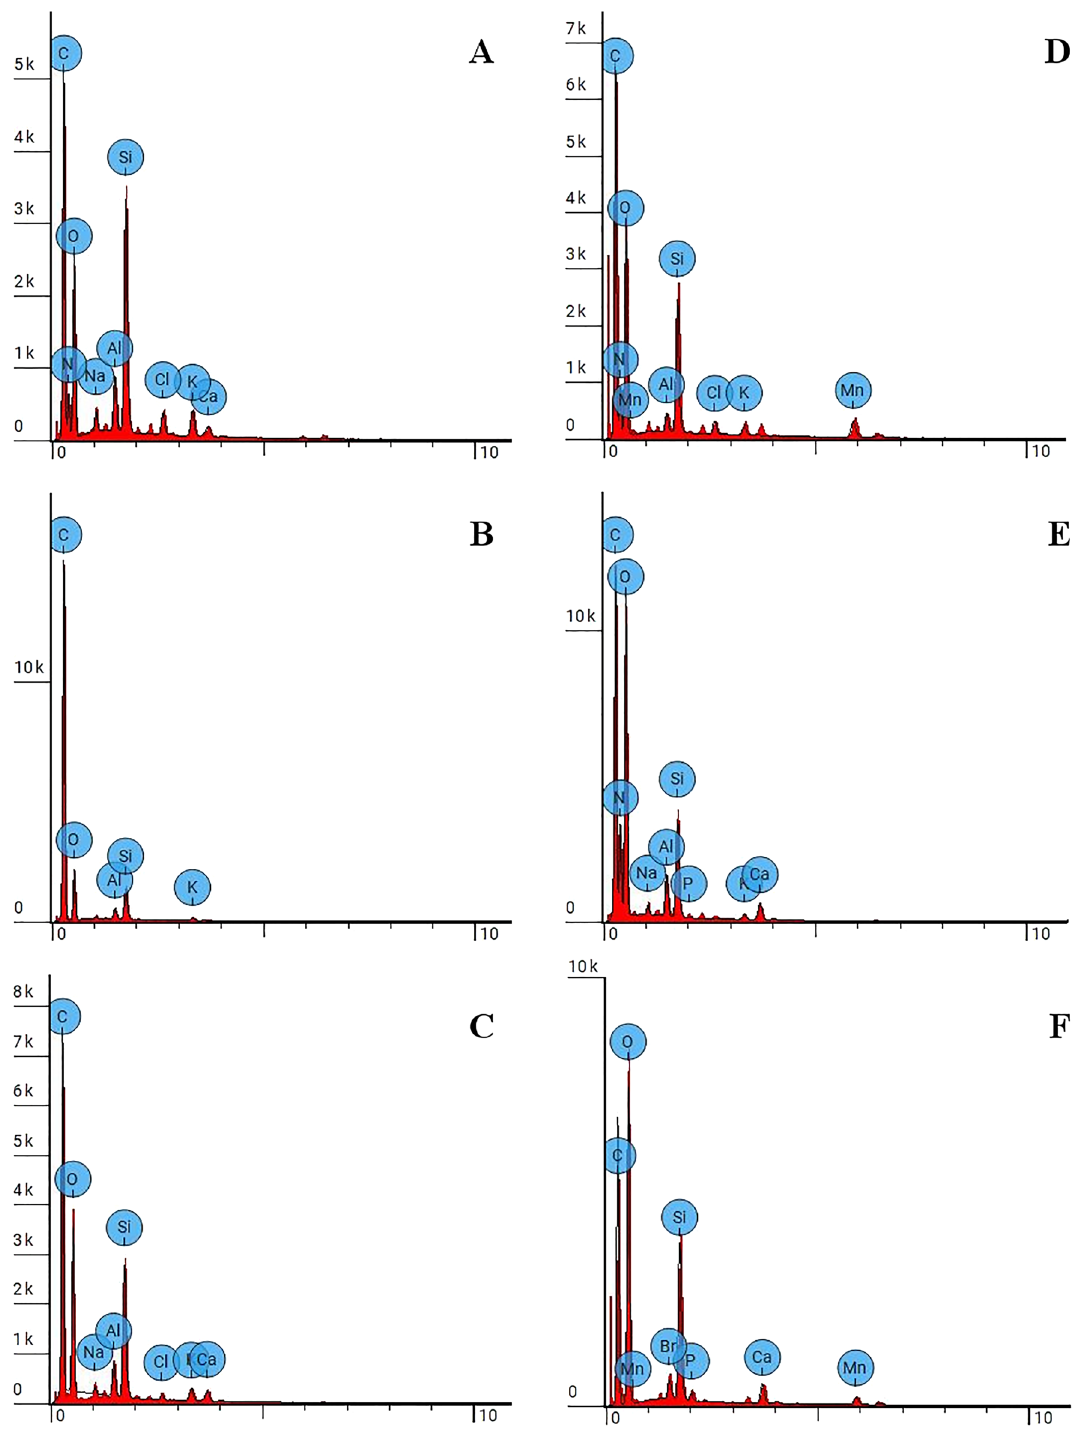
Figure 7. SEM–EDS spectra of bitumen residues identified on samples 1 ( A ), 2 ( B , C ), 3 ( D ), 4 ( E ), and 5 ( F ). Samples 1–4 are from Saradj-Chuko grotto and sample 5 is from Mezmaiskaya